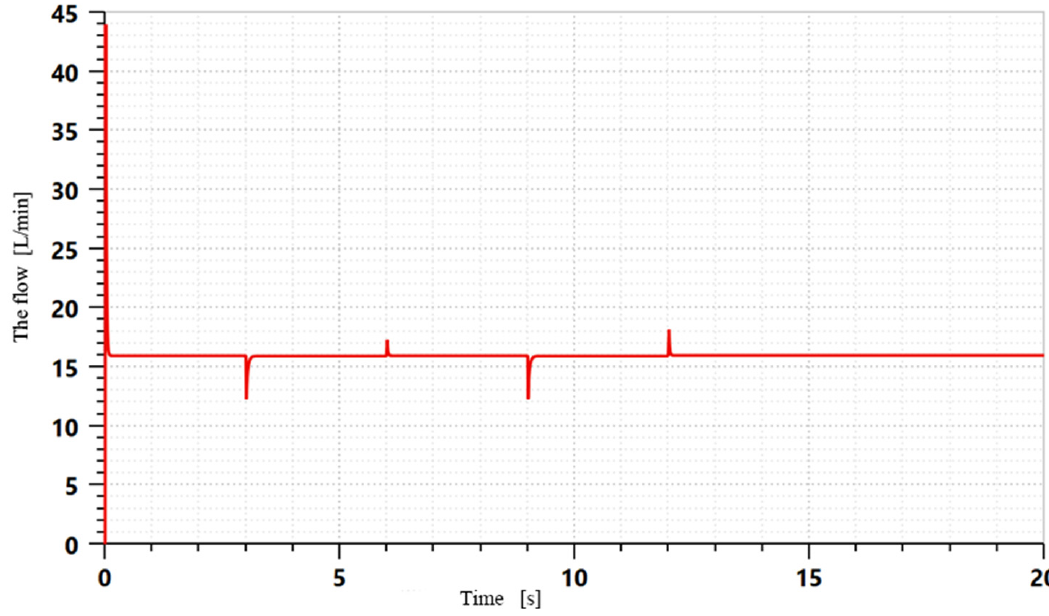
Figure 6. Step change curve of flow rate with differential pressure.